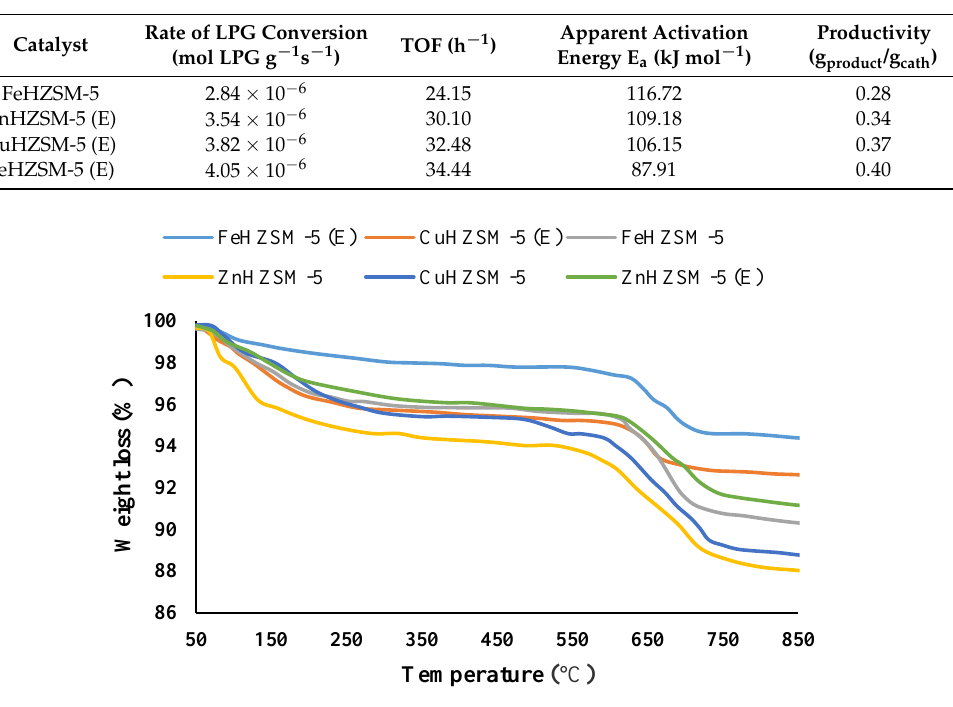
Figure 8. TGA analysis of spent 4 wt. % FeHZSM-5, 4 wt. % CuHZSM-5 and 4 wt. % ZnHZSM-5 catalysts in presence and absence of electric field.